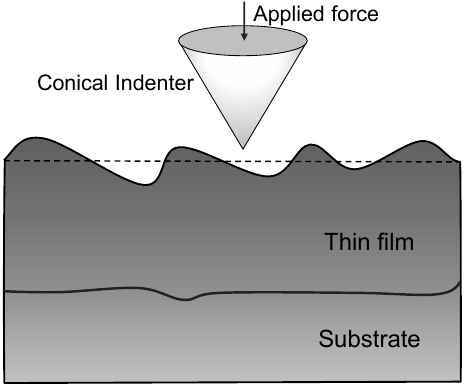
Figure 1. Schematic representation of indentation test on the undulating surface.